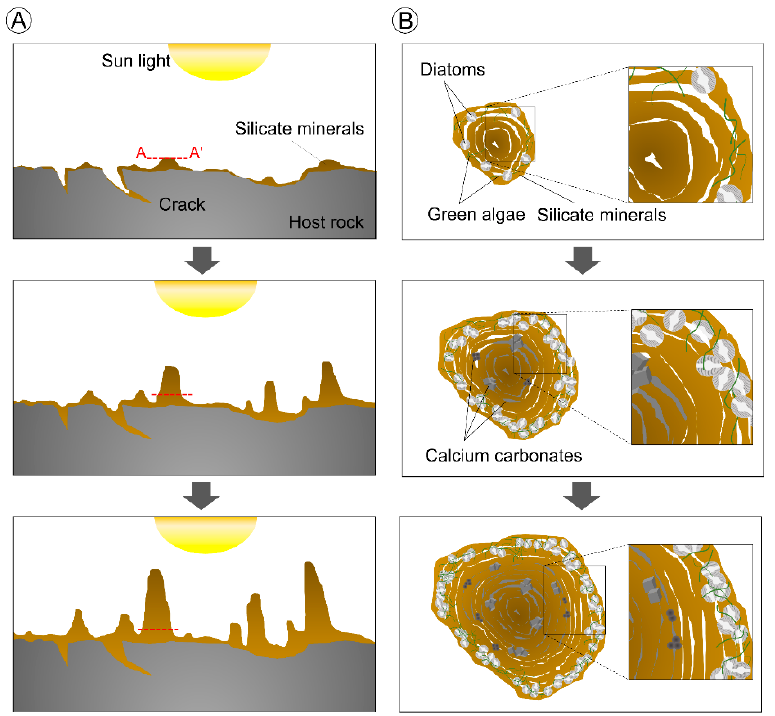
Figure 10. Formation mechanism (temporal growing) of stalactite minerals. ( A ) state from a side face; ( B ) state of the cross-section.